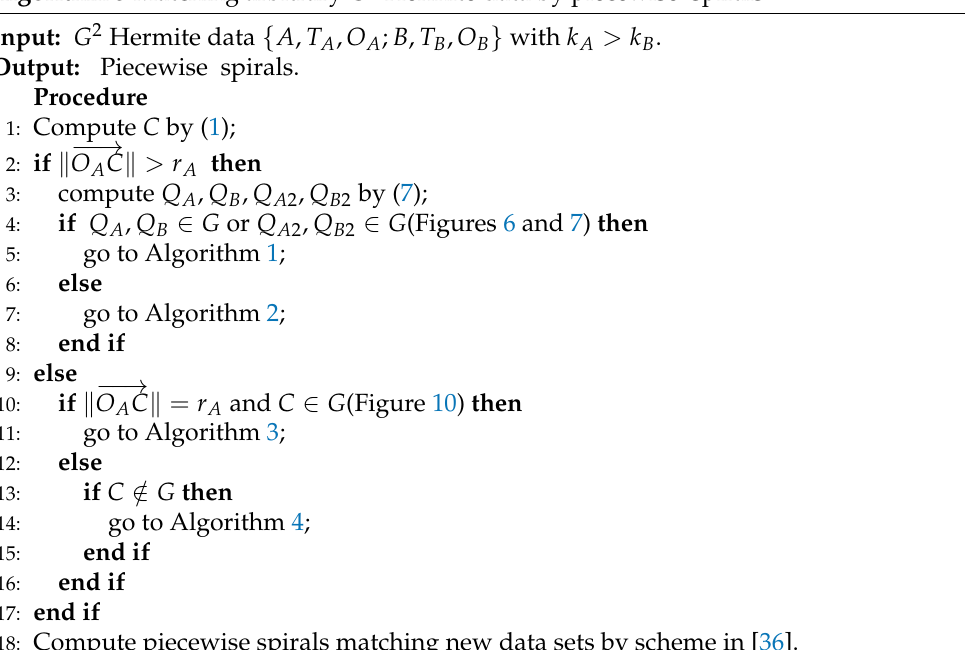
Algorithm 5 Matching arbitrary G 2 Hermite data by piecewise